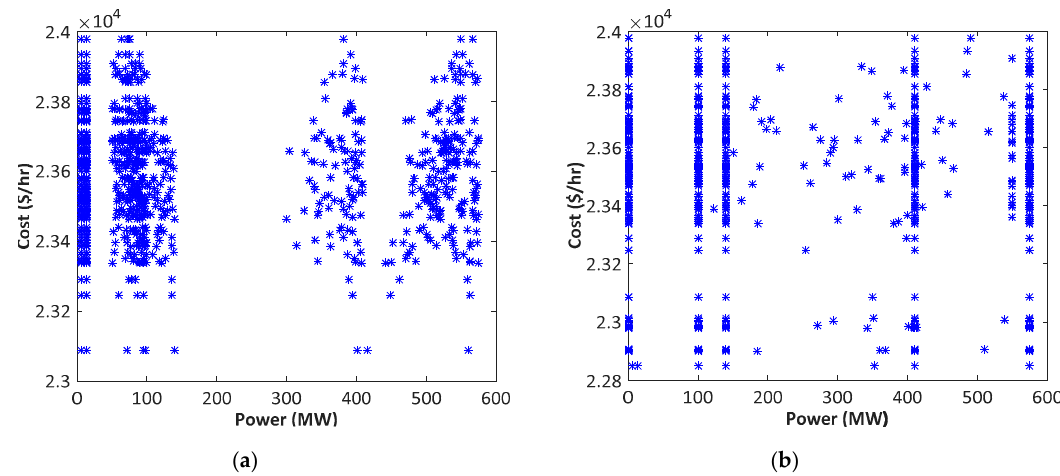
Figure 5. Bats positions in the BA ( a ) at the start and ( b ) after 1000 iterations (seven-unit system with renewables).